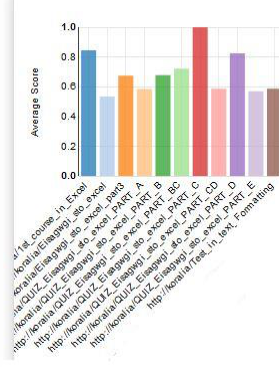
Figure 14. Bar chart with the average score per